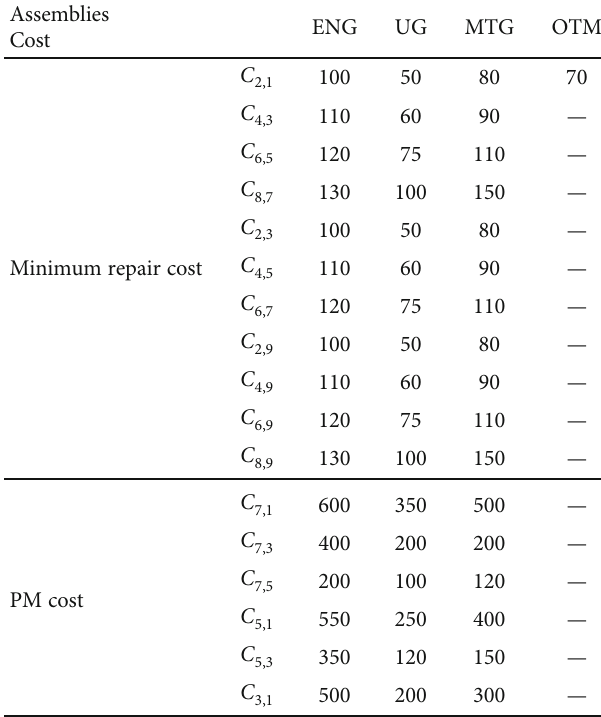
Table 4: State performance of assemblies. Table 5: Minimum repair costs and PM costs of